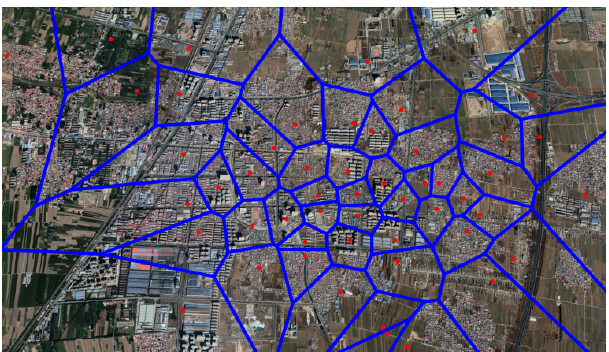
Figure 6. Urban area zoning. Table 2. Commuting